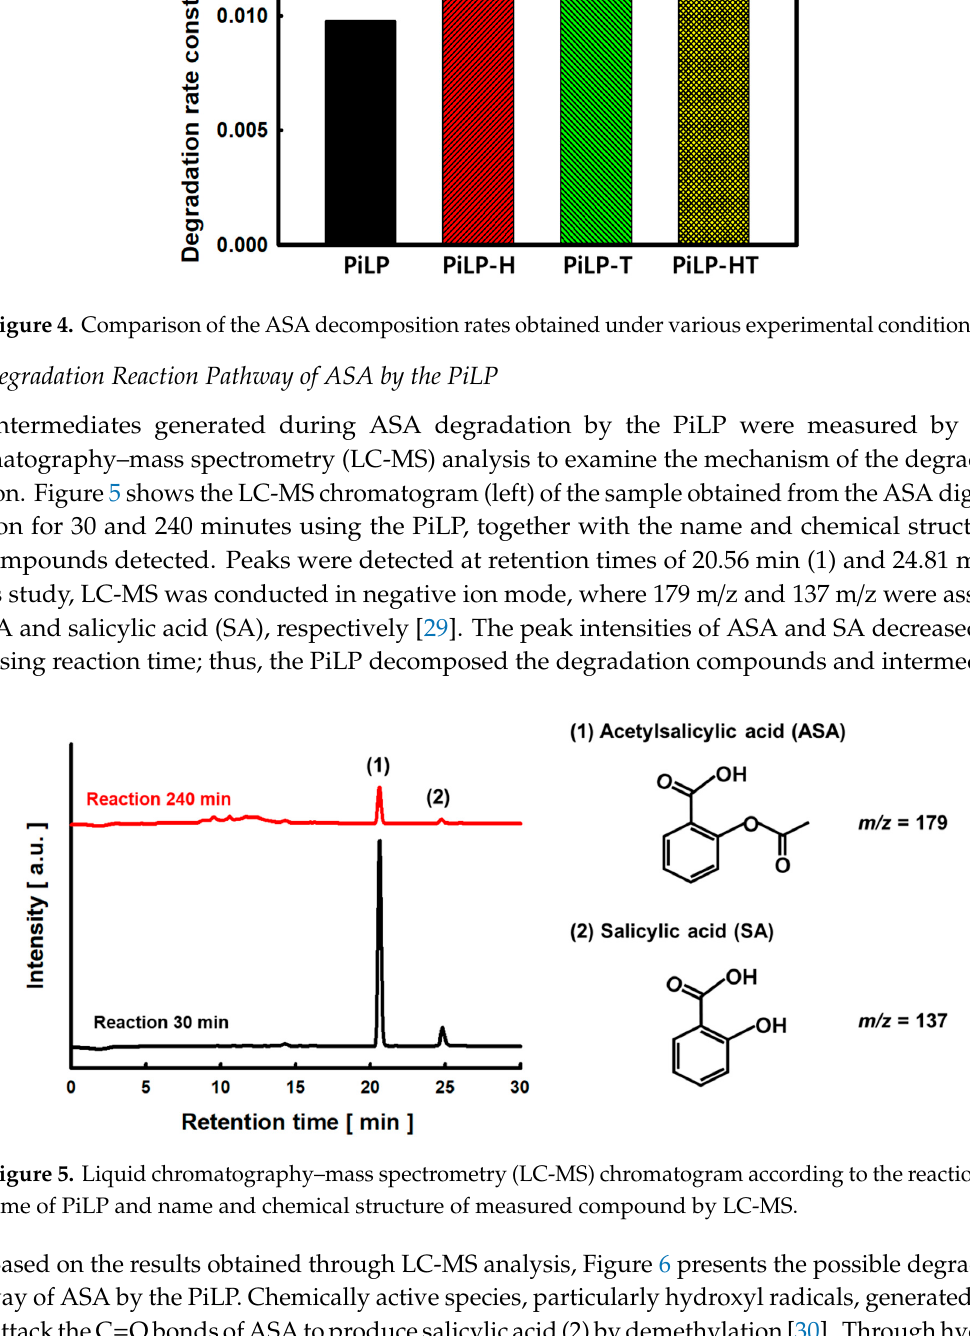
Figure 5. Liquid chromatography–mass spectrometry (LC-MS) chromatogram according to the reaction time of PiLP and name and chemical structure of measured compound by LC-MS.